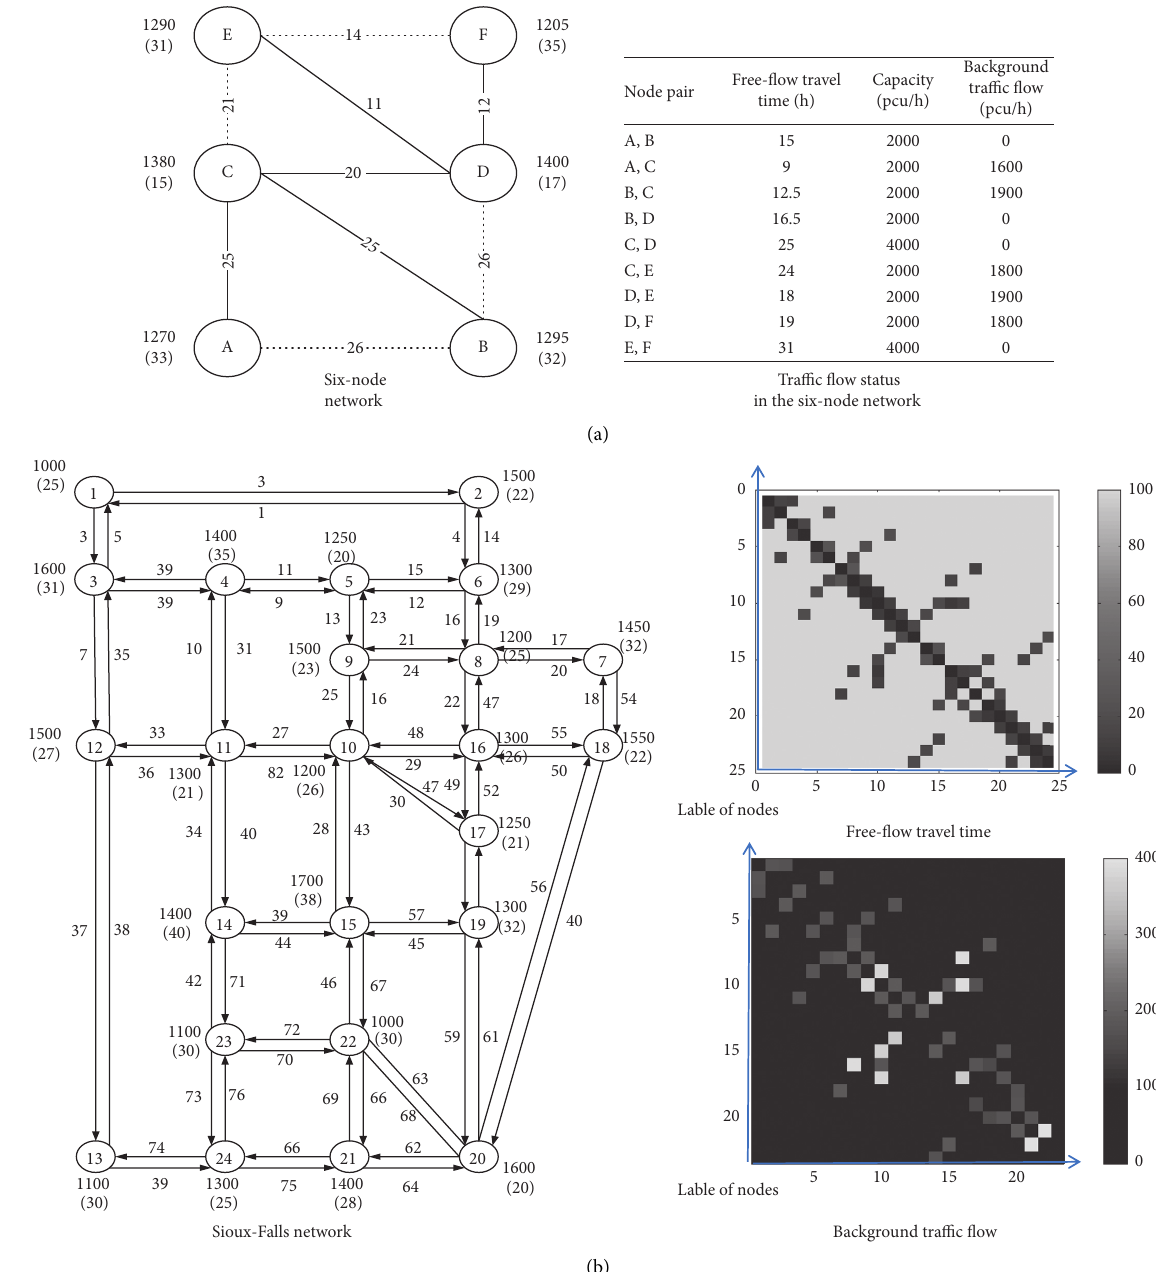
Figure 5: Classic problems. (a) Six-point problem. (b) Sioux-Falls